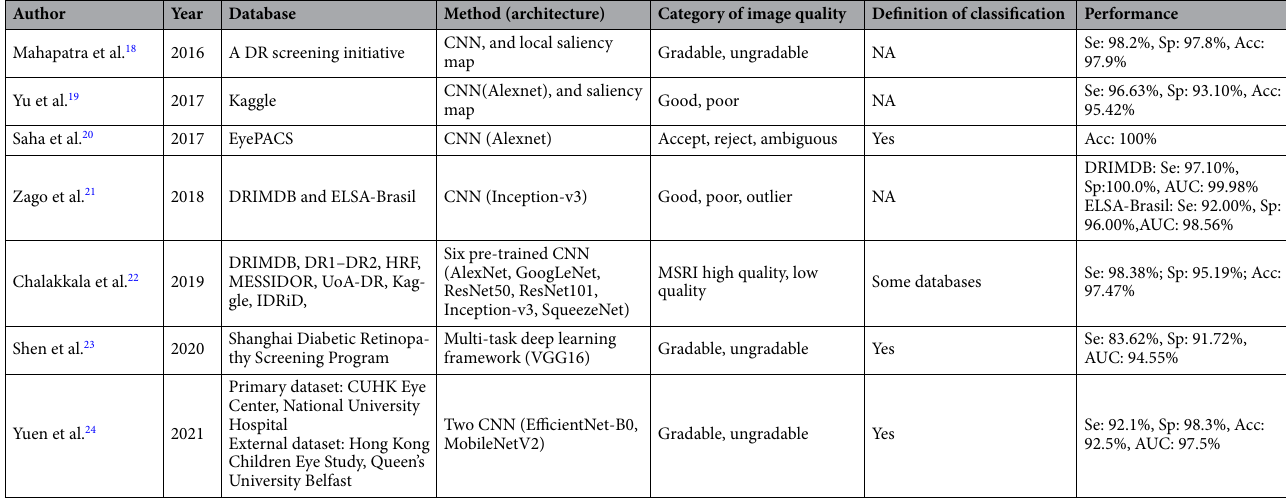
Table 1. Review of studies using CNN method to assess retinal image quality. DL deep learning, CNN convolutional neural network, MSRI medically suitable retinal image, NA not available, Se sensitivity, Sp specificity, Acc accuracy, AUC area under the